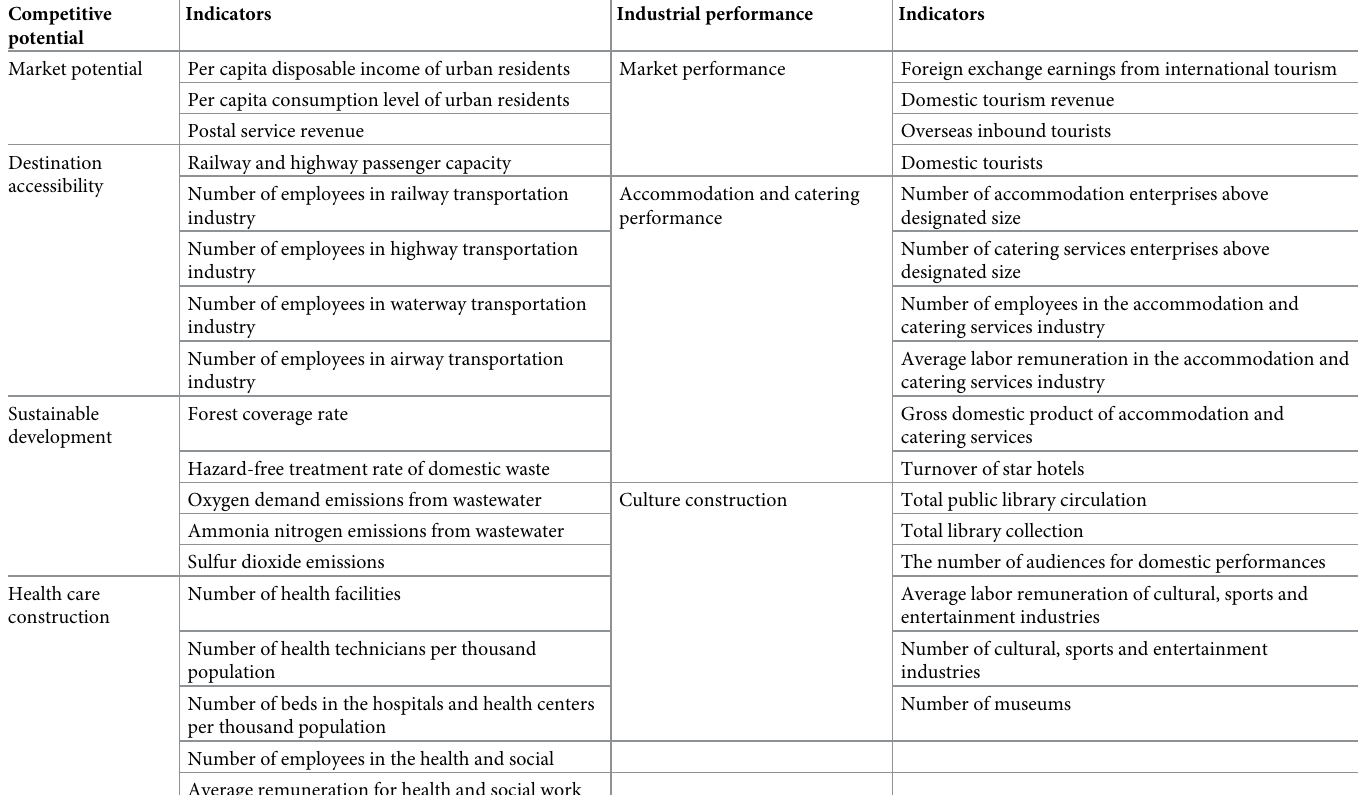
Table 2. Evaluation index of tourism industry